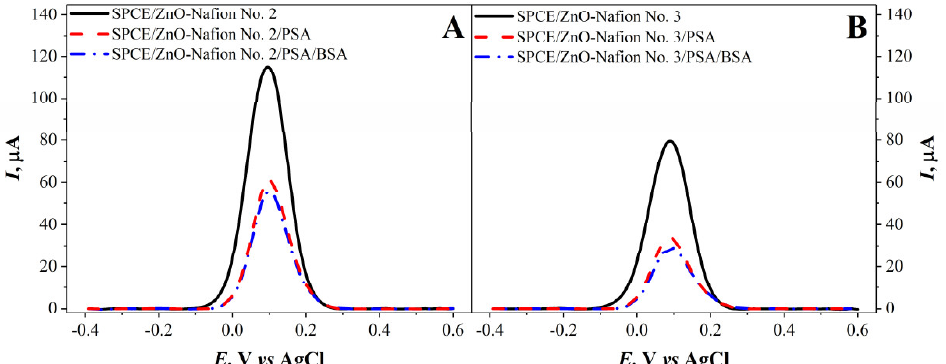
Figure 6. Differential pulse voltammograms of SPCE/ZnO-Nafion No. 2 ( A ), SPCE/ZnO-Nafion No. 3 ( B ) before (—) and after immobilization of PSA (- - -) and blocking the remaining free surface area by BSA (— ·). Potential range from −0.4 to +0.6 V with a step size of 4 mV, pulse height of 0.05 V, pulse period of 100 ms, pulse width of 50 ms in 0.01 M PBS, pH 7.4, containing 2.5 mM [Fe(CN 6 )] 3−/4− .